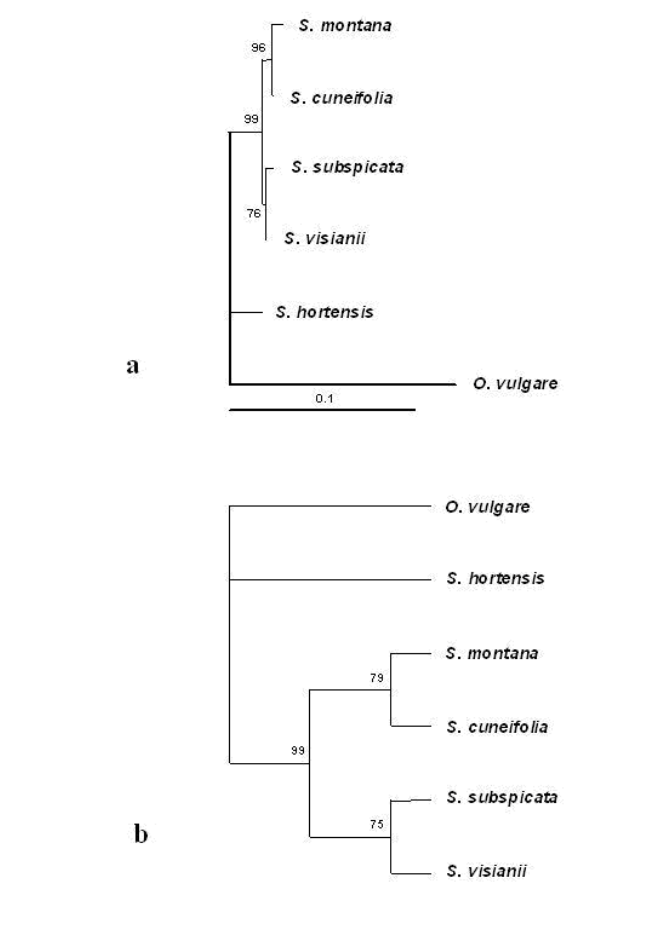
Figure 2 . Phylogenenetic relationship of Satureja species based on ITS